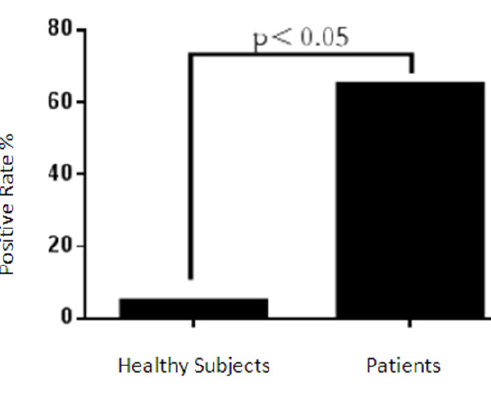
Figure 1: Comparison of IgG antibody positive rate between healthy subjects and patients.